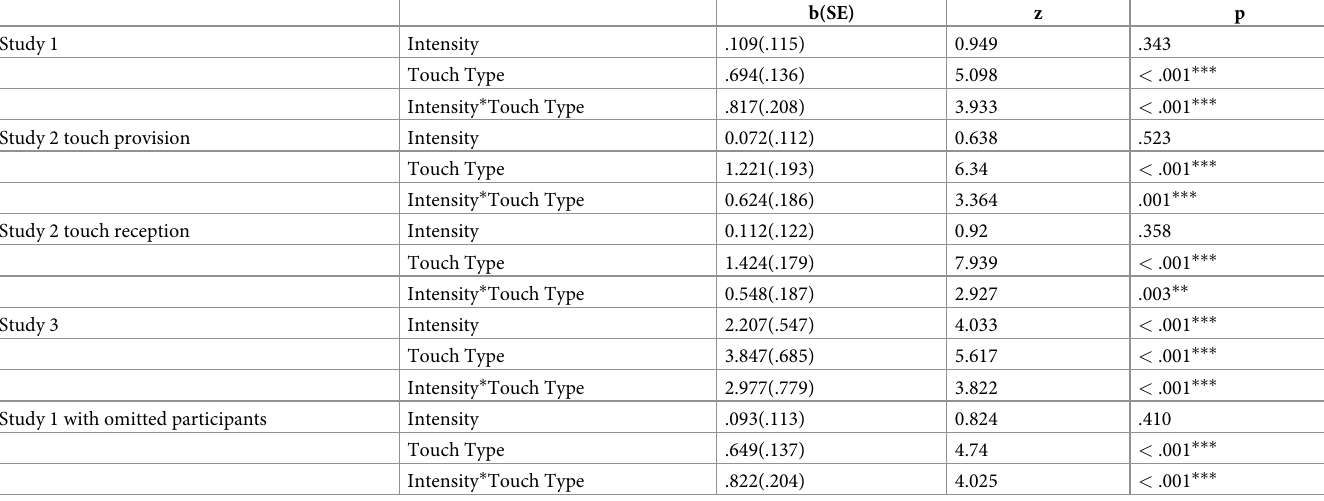
Table 2. The effect of intensity measured by dichotomous situation classifications and touch type on touch preference analyzed using cumulative link